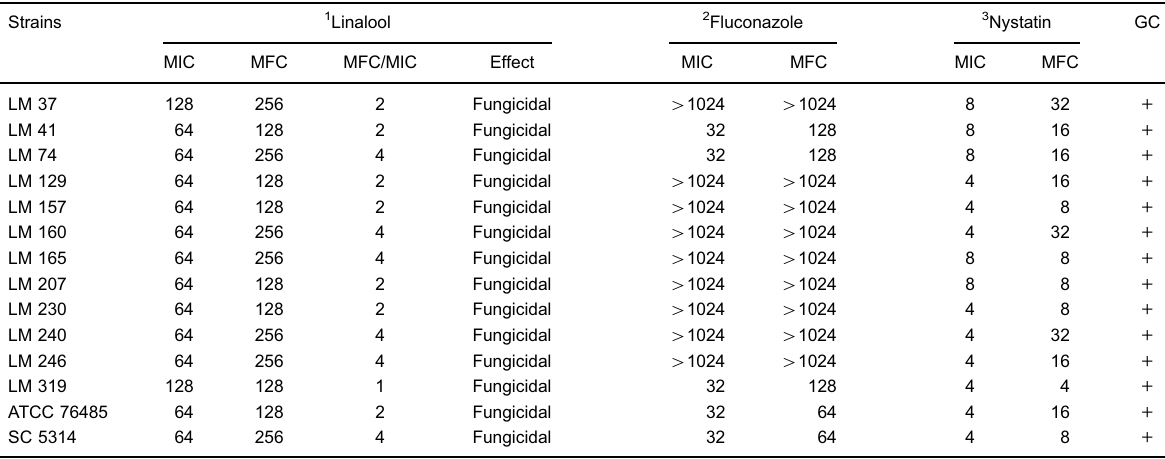
Table 1. Minimum inhibitory concentration (MIC) values and minimum fungicidal concentration (MFC) ( m g/mL) of linalool, fl uconazole, and nystatin against C. albicans strains by broth microdilution. Strains